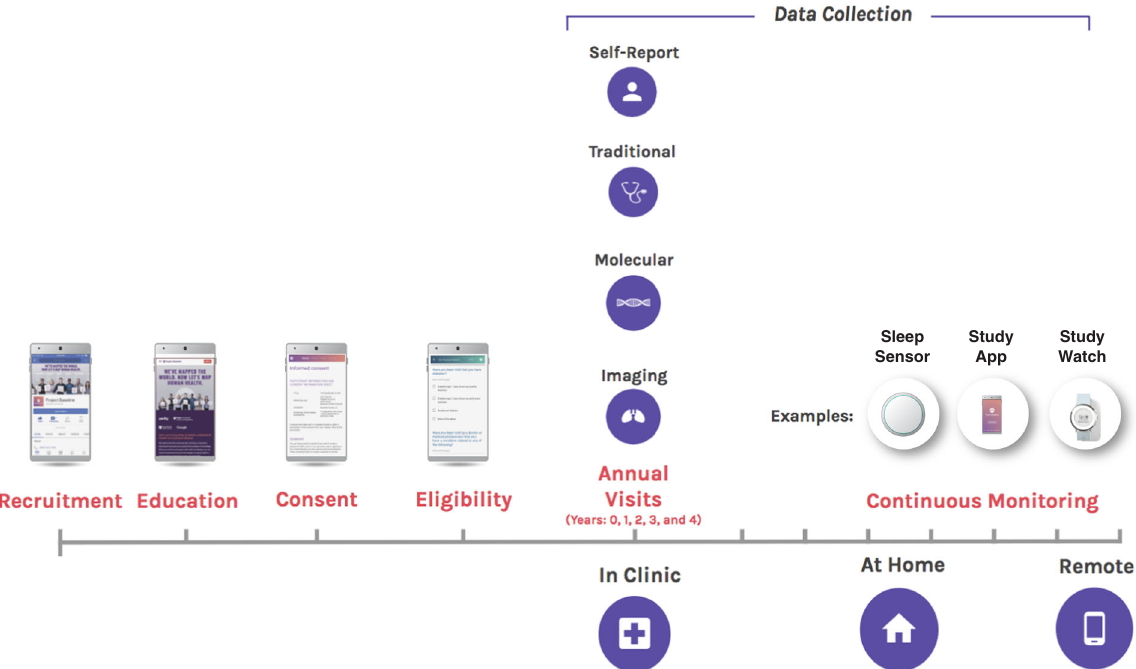
Fig. 1 Overview of participant fl ow. Participants are recruited and screened. After the initial screening period, participants have annual follow-up visits in person. A broad range of health measurements are conducted in clinic, at home, and remotely. Participants are able to provide input and have access to communication with study staff on a more continuous basis between study visits. The current duration of the follow up is to occur over the course of the next four years. * Study watch image used with permission from Verily